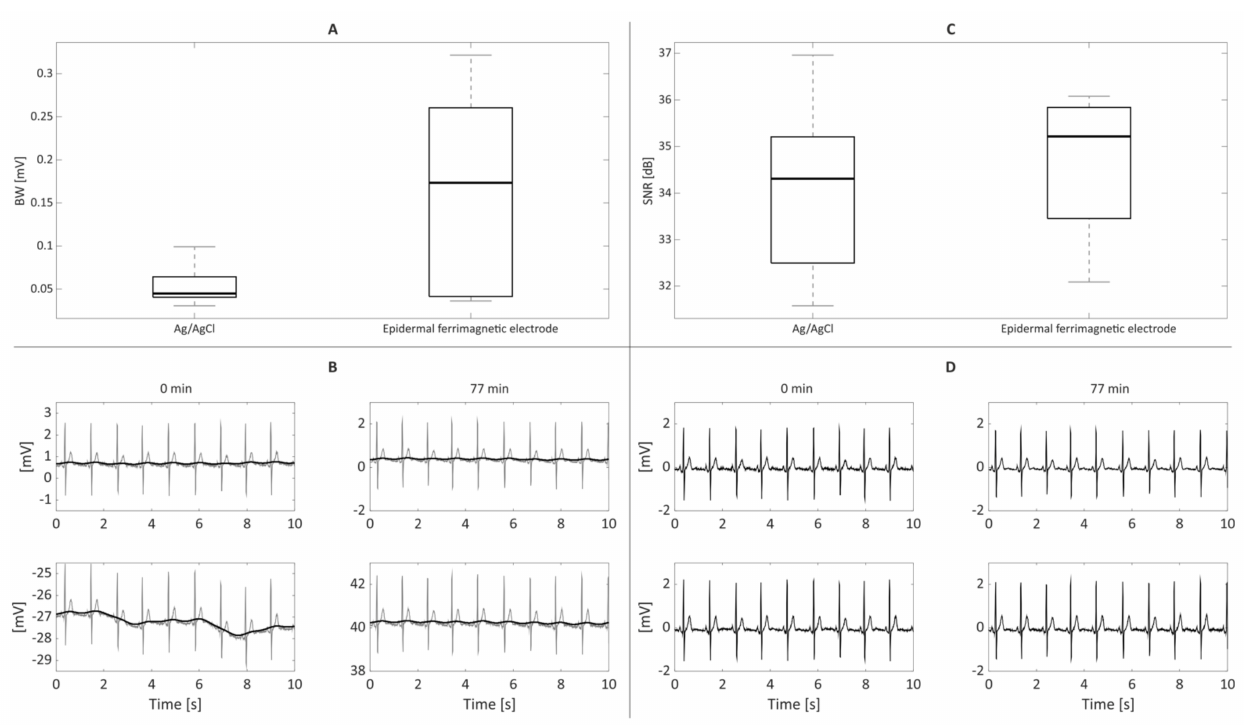
Figure 5. On the left, BW results ( A ) are reported along with the raw ECG signals (( B ), in grey) recorded at the first (i.e., 0 min, left column) and last recording sessions (i.e., after 77 min, right column) with the corresponding BW artifact (in black) for the Ag/AgCl (( B ), top) and proposed ferrimagnetic-conductive epidermal electrodes (( B ), bottom). On the right, SNR results for the different electrode types ( C ) are depicted, while in ( D ) the filtered ECG signals recorded when the recording session started (0 min, left column) and at its end (i.e., after 77 min, right column) by exploiting the Ag/AgCl (( D ), top) and proposed ferrimagnetic-conductive epidermal electrodes (( D ), bottom) are